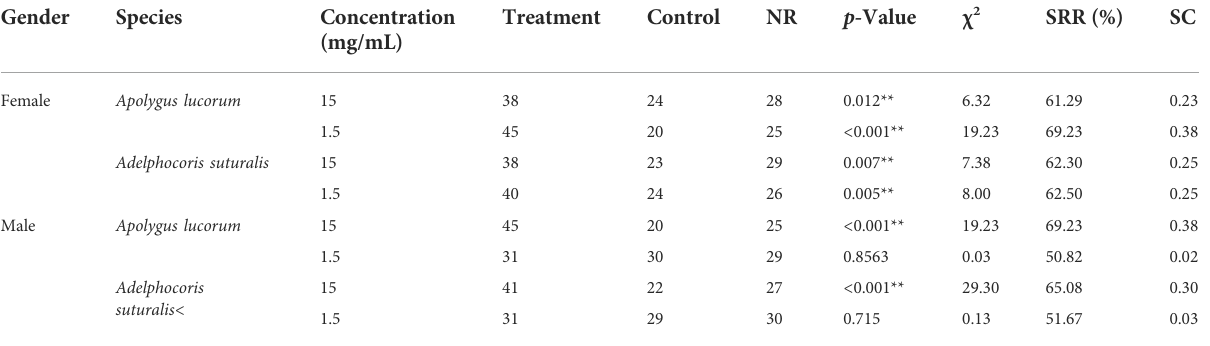
TABLE 2 The olfactory responses of two pest mirid bugs to synthetic tetradecane, measured in laboratory tests. Gender Species Concentration Treatment (mg/mL)